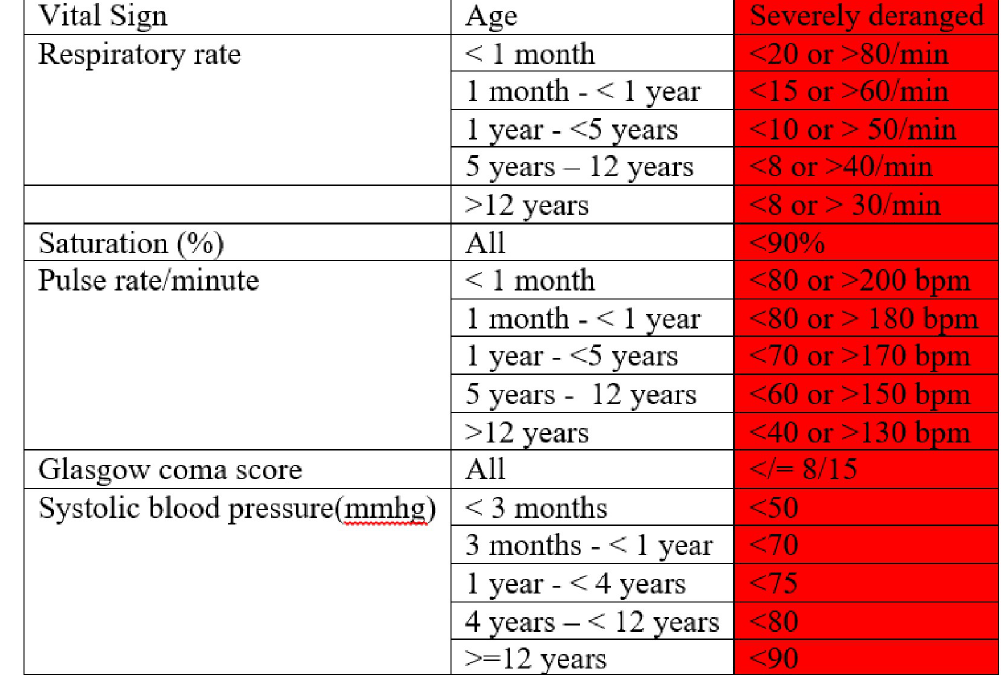
Fig 1. Cut–offs for severely deranged vital signs (13,